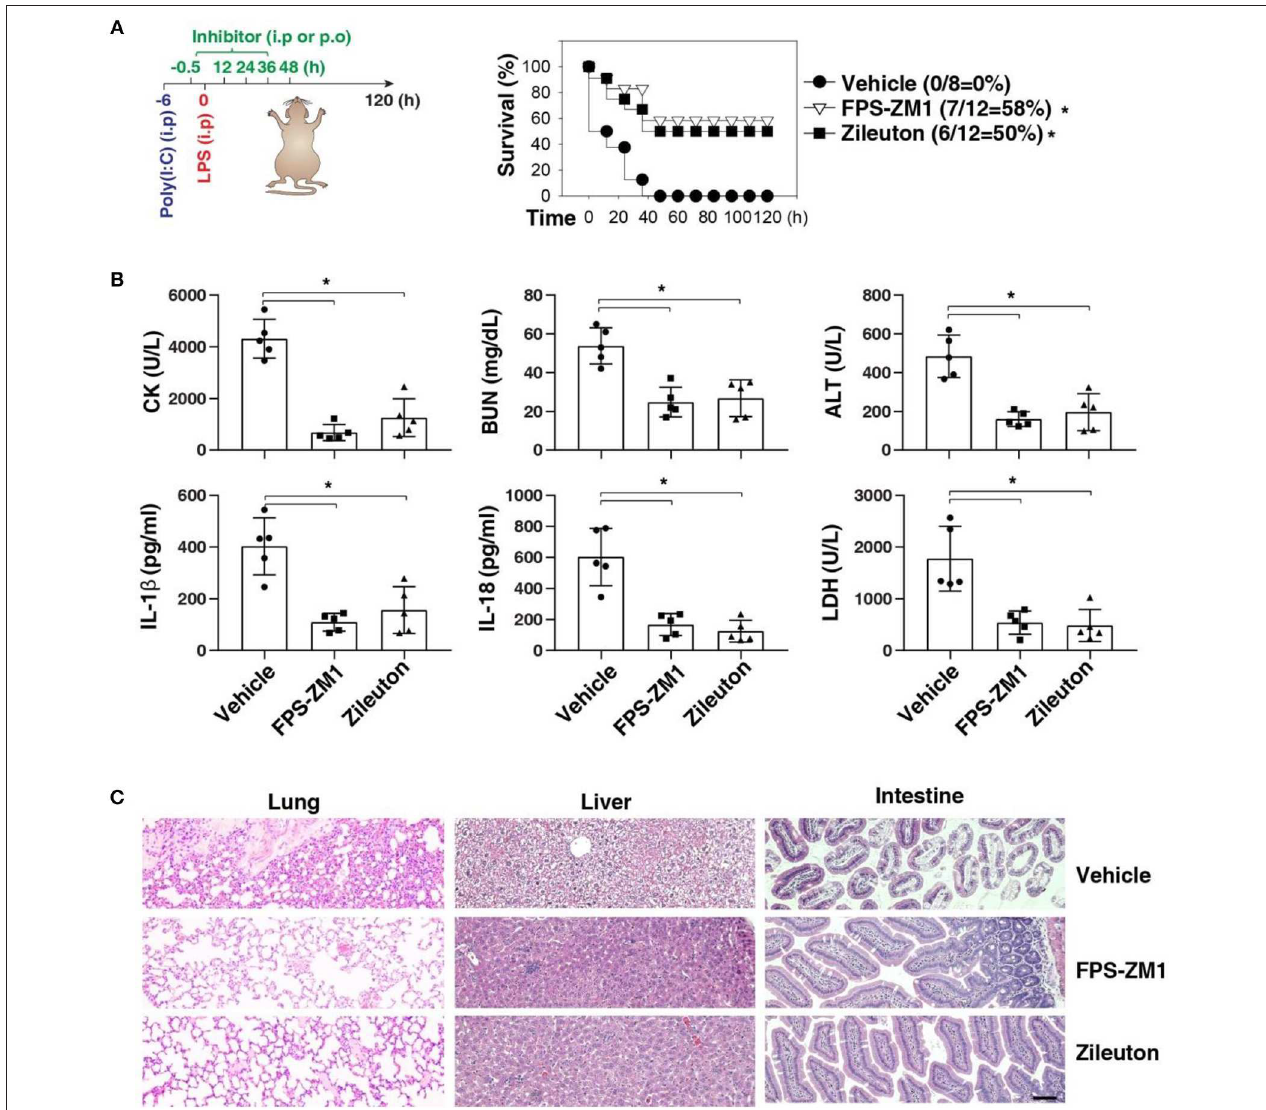
FIGURE 6 | Pretreatment of FPS-ZM1 and zileuton protects against septic shock. (A) Survival of indicated mice primed with poly(I:C) (10 mg/kg, i.p.) and then challenged 6h later with LPS (2 mg/kg, i.p.) in the absence or presence of the administration of FPS-ZM1 (10 mg/kg, i.p.) or zileuton (30 mg/kg, p.o.) at − 0.5, + 12, + 24, + 36, and + 48h. n = 8–12 mice/group, * P < 0.05, Kaplan-Meier survival analysis. (B,C) In parallel to panel A, quantitation of indicated serum markers (B) or hematoxylin/eosin staining of indicated tissues (C) in poly(I:C)-primed mice challenged with LPS at + 3h (bar = 100 µ M). n = 5 mice/group, * P < 0.05, ANOVA LSD test. Animal data represent two independent